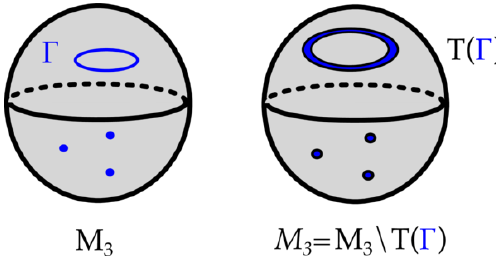
Figure 1 . On the left hand side the three-cycle M 3 is shown, with the charge distribution (cid:26) that is located along (cid:0). On the right hand side, a tubular neighborhood T ((cid:0)) is excised and the resulting manifold is M 3